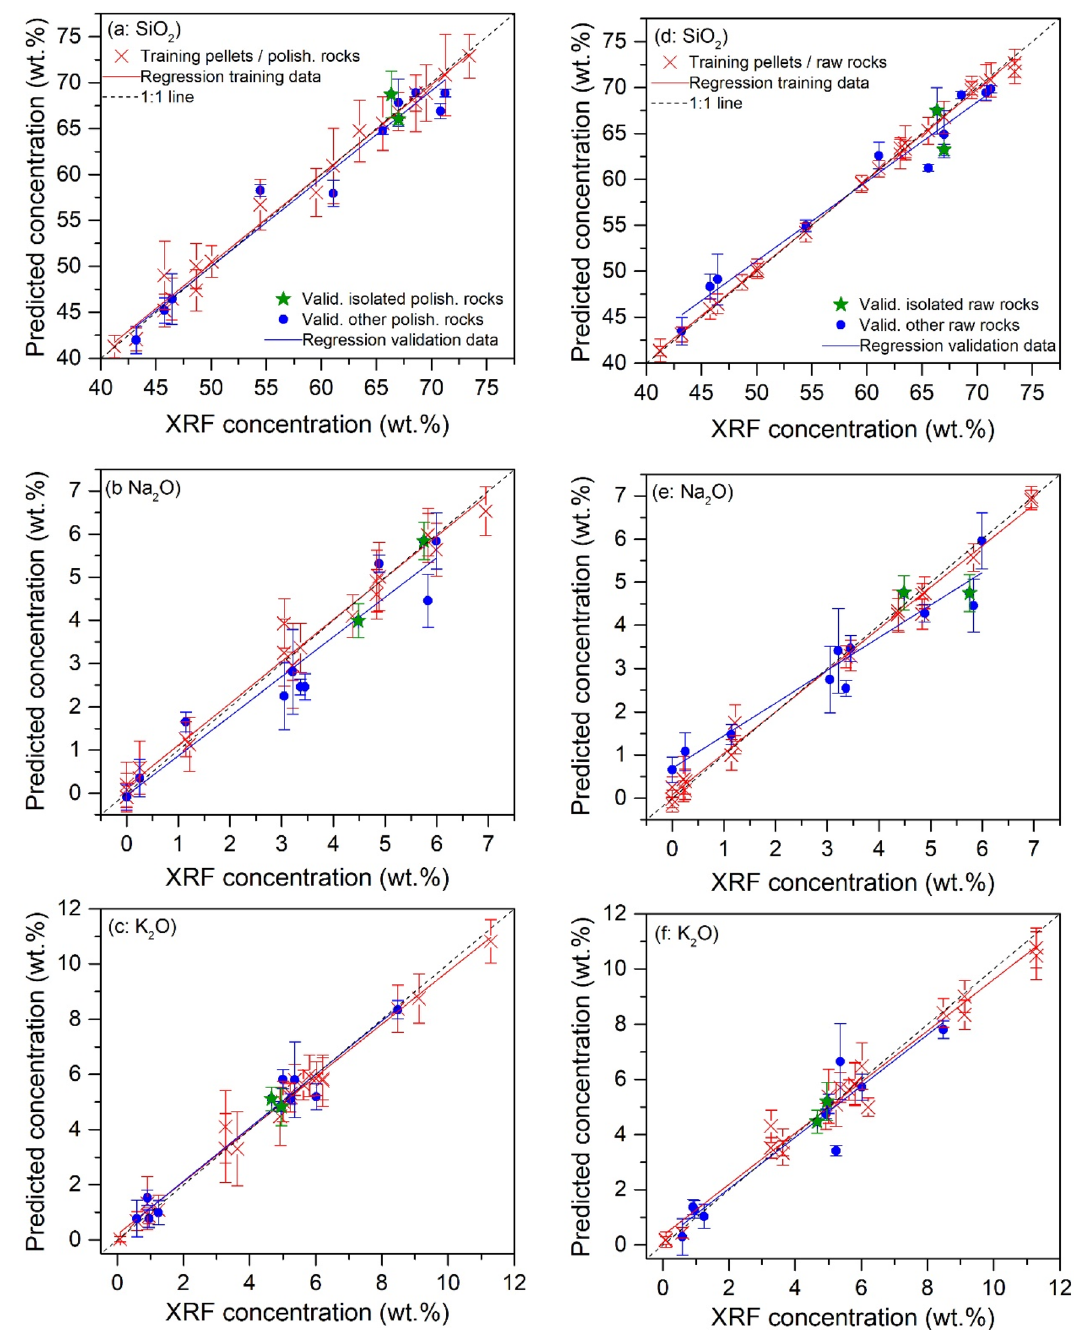
Figure 8. Presentation of the transfer learning-based calibration models respectively for the 3 compounds SiO 2 ( a , d ), Na 2 O ( b , e ) and K 2 O ( c , f ), with training data (red crosses) and their linear regressions (red lines); validation data for the validation polished ( a – c ) and raw ( d – f ) rocks (solid blue points) including isolated polished and raw rocks (solid green stars), together with their linear regressions (blue lines). Ground-truth diagonals are plotted in dotted lines in the figures as a reference for the models. The error bars of the presented data correspond to the standard deviations ( ± SD ) of the calculated or predicted concentrations for a given training or validation sample. See the text for the details of standard deviation